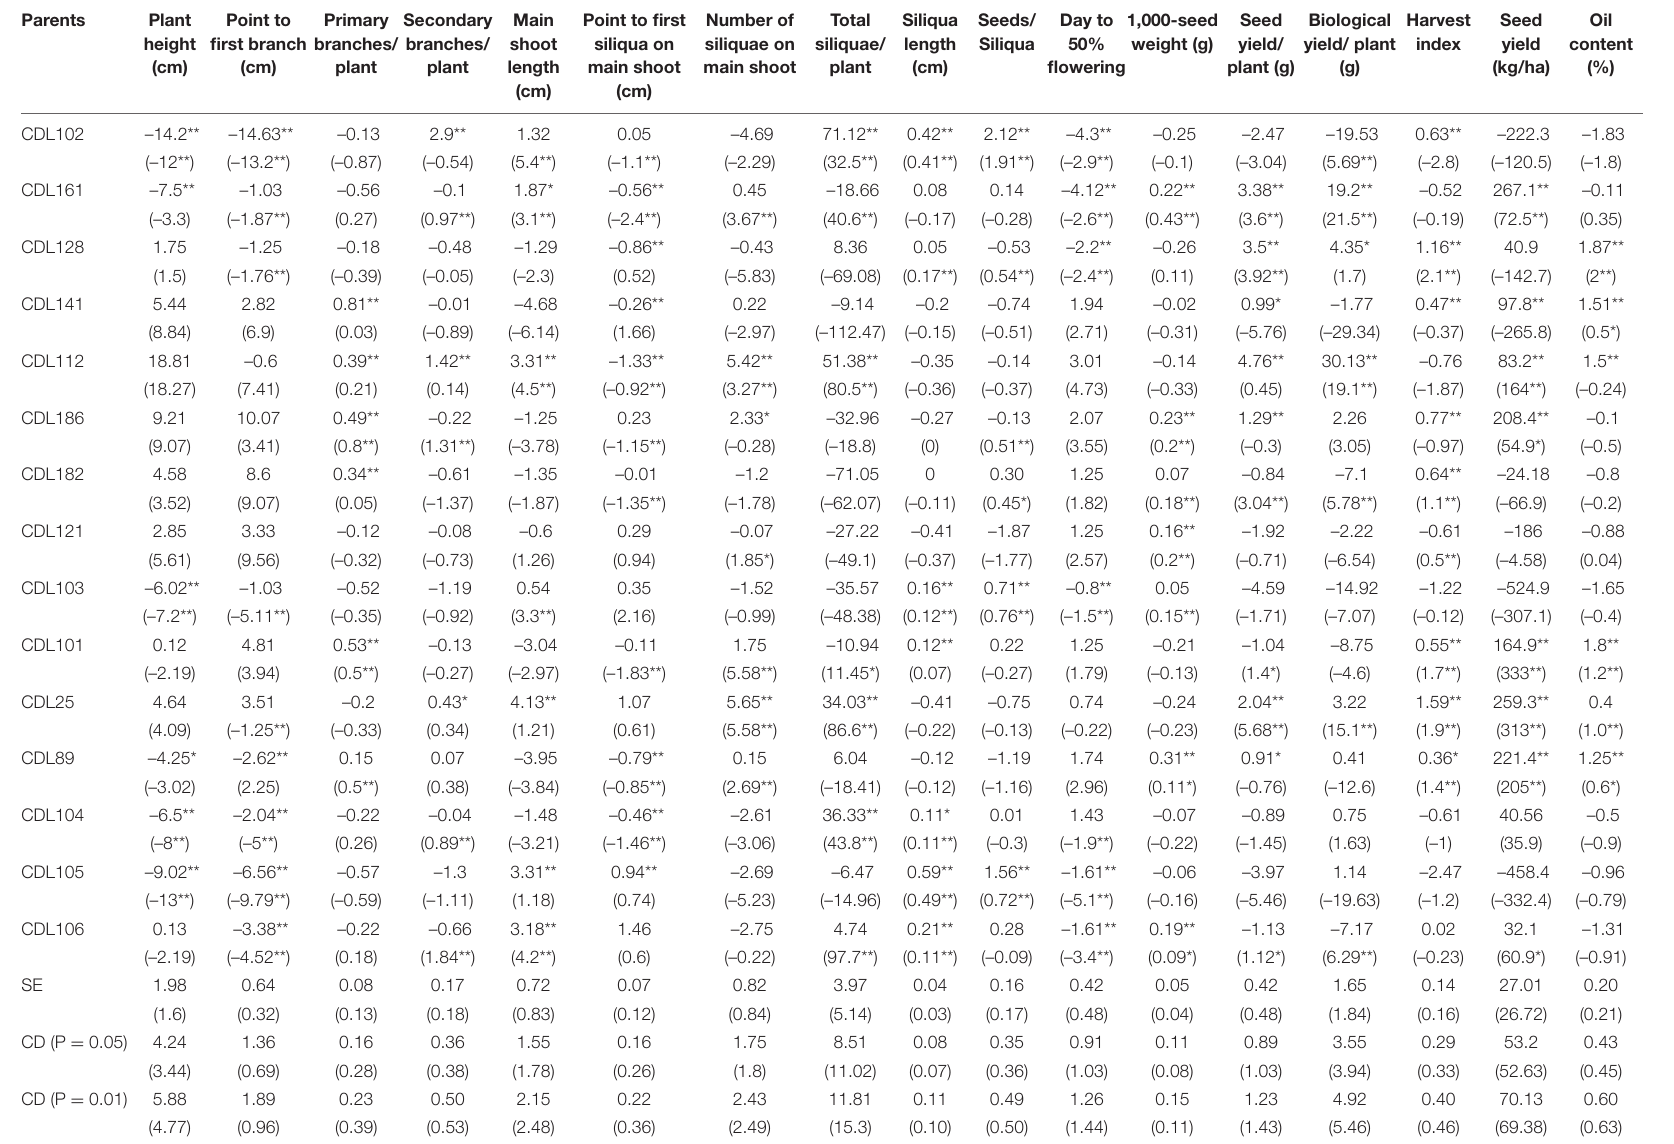
TABLE 4 | General combining ability (GCA) effects of 15 parental lines and variance components for different traits in CDLs along with their hybrids under both rainfed and irrigated conditions.